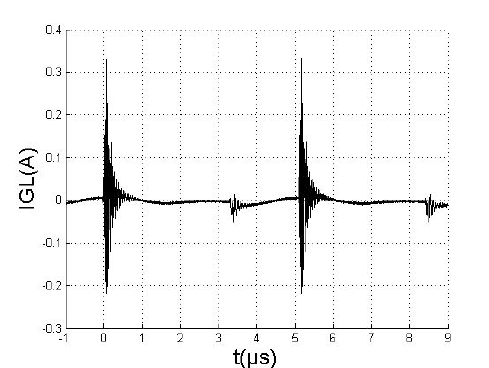
Figure 25: Experimental waveform of the current i